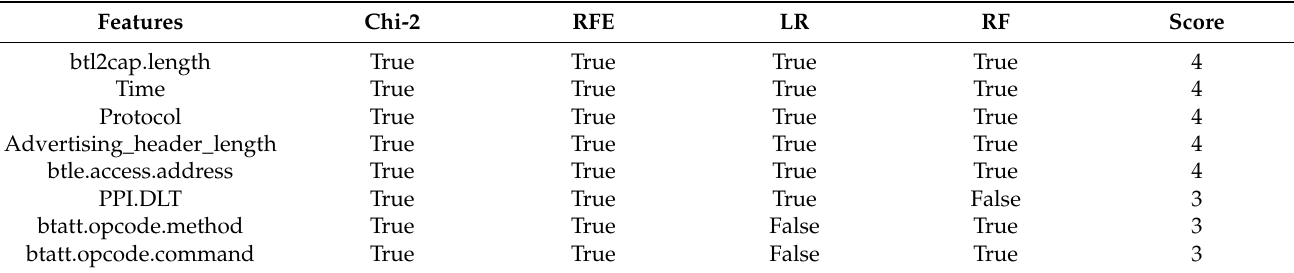
Table 4. Univariate selection score of BLE selected